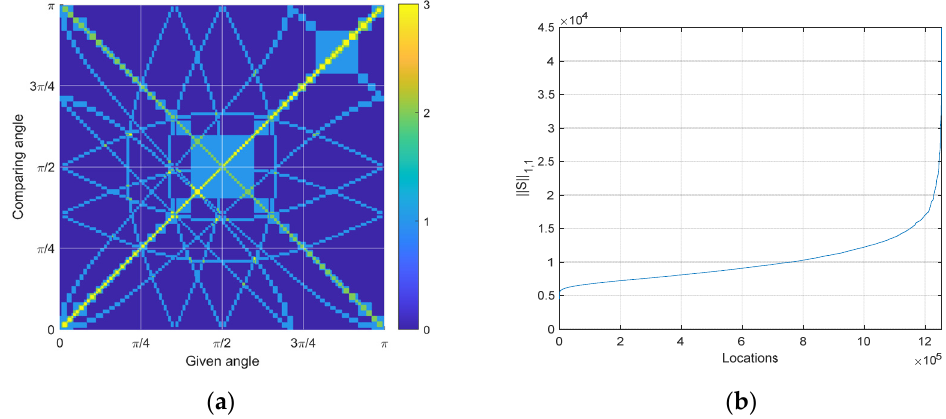
Figure 6. Similarity analysis. ( a ) The similarity matrix for the given receiver configuration shown is Figure 5a. The higher value indicates the higher similarity between the given and comparing angle; ( b ) The sorted distribution of similarity matrix L 1,1 norm for all possible combinations of three receiver